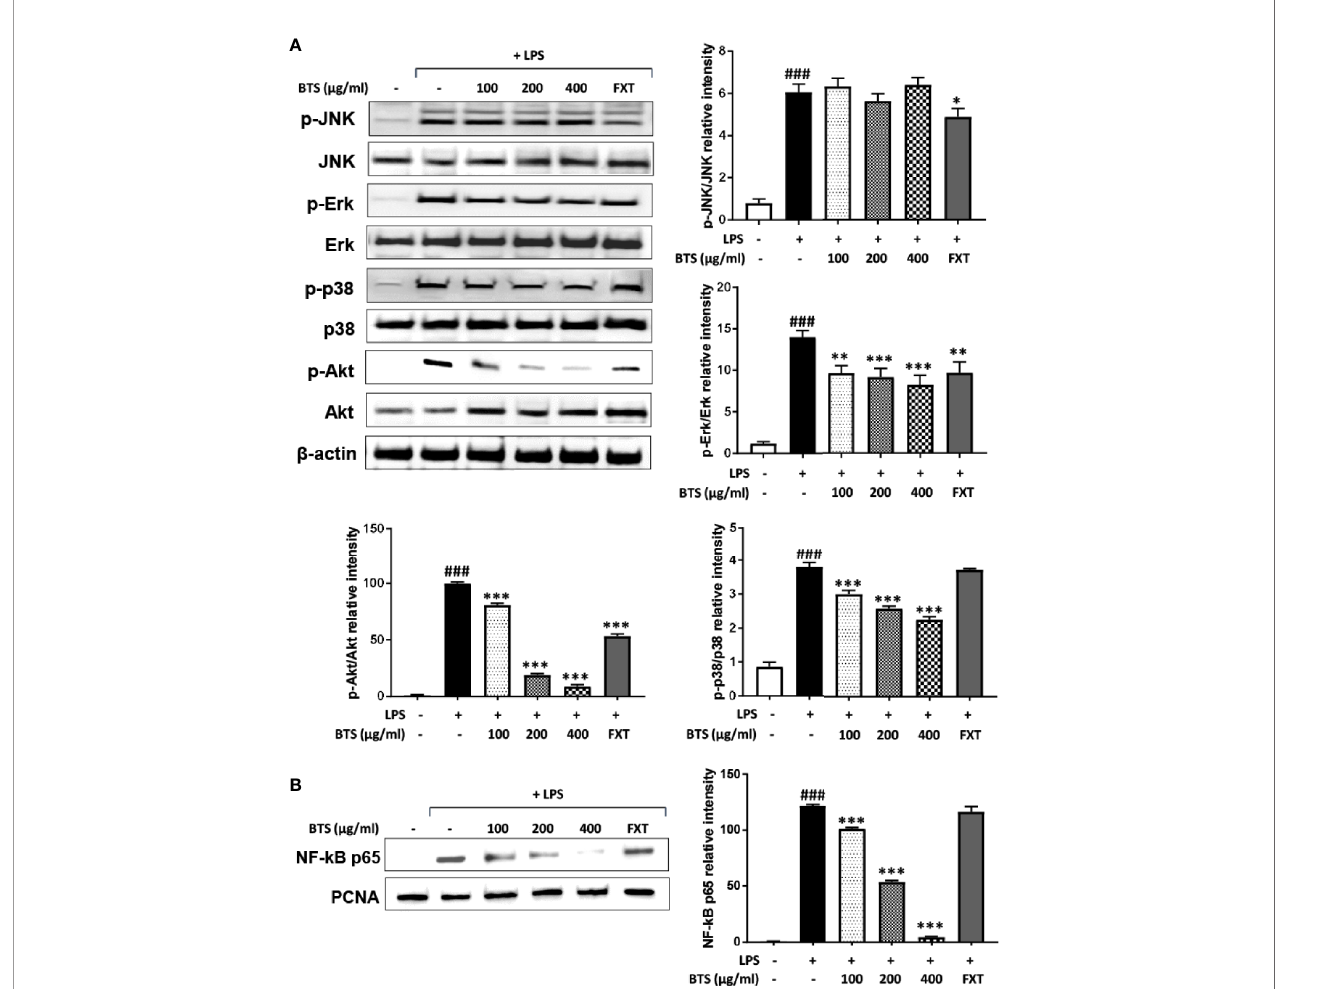
FIGURE 7 | Effect of BTS on the phosphorylation of MAPKs and Akt and NF- k B activity in BV2 cells. (A) BV2 cells were pretreated with BTS for 1 h and then stimulated with LPS (100 ng/ml) for 15 min. Levels of p-JNK, JNK, p-Erk, Erk, p-p38, p38, p-Akt, and Akt were determined by western blotting. b -actin was used as a loading control. (B) BV2 cells were pretreated with BTS for 1 h and then stimulated with LPS (100 ng/ml) for 1 h. Nuclear extracts were analyzed by western blotting using NF- k B p65 antibody. PCNA was used as a loading control. The data represent three independent experiments. The data are expressed as the mean ± SD (one-way ANOVA: ### p < 0.001 vs. untreated control; *p < 0.05, **p<0.01, ***p < 0.001 vs. LPS-treated